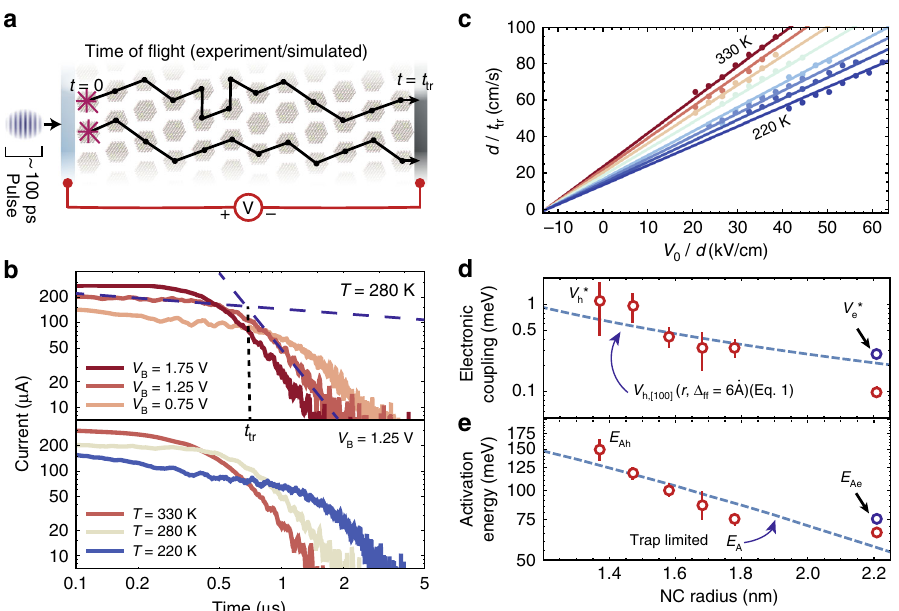
Fig. 3 Trap-limited transport in NC semiconductor. a Schematic of time-of- fl ight (TOF) photocurrent transient measurements. b Hole transients measured at various biases and temperatures on an NC solid ( r = 2.21 nm). c Plot of the hole velocity, d / t tr , versus applied fi eld, V B / d , at various temperatures. Solid lines indicate the fi t to Eq. (4). d Electronic coupling and e activation energy extracted from TOF measurements as a function of the NC radius r compared to computed V h[100] and E A assuming trap-limited transport (dashed lines); error bars correspond to the standard error in the extracted E V * h and Ah